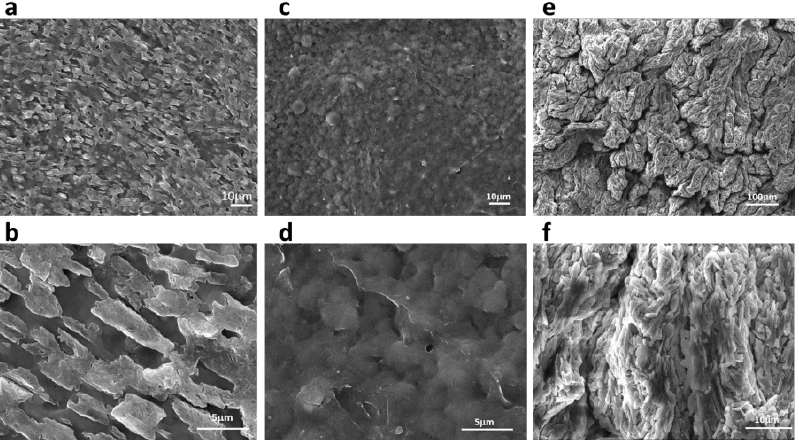
Figure 3. The SEM image of adhesive film. ( a – d ) Surface morphology of adhesive film; ( e , f ) Cross- section morphology of adhesive film. Preparation conditions of KGM/CA/PVA ternary blend adhe- sive: the content of KGM and PVA were 4.5% and 3.0% respectively, the pH value is 5.0. ( a , b ) the content of the CA was 2.5%, the preparation temperature was 40 °C; ( c – f ) the content of the CA was 3%, the preparation temperature was70 °C.